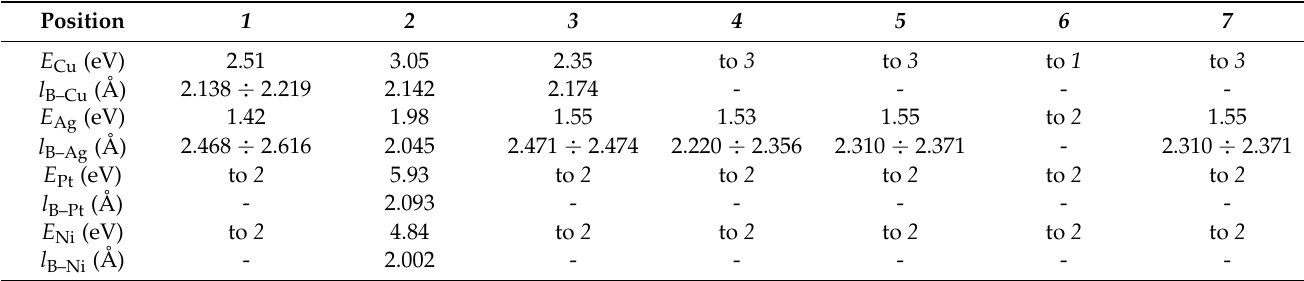
Table 1. Adsorption energies (see Equation (1)) for metal atoms Cu, Ag, Pt, and Ni adsorbed on different sites (see Figure 2) of the borophene-graphene bilayer. Ranges of bond lengths between metal and boron atoms are also presented. Record “to N ” indicates that the metal atom moved to position number N during geometry optimization.